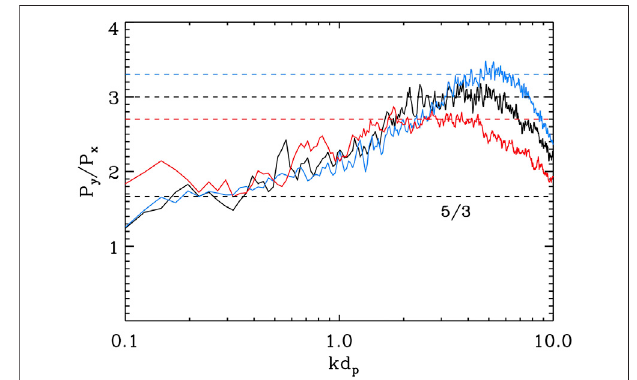
FIGURE 4 | Hybrid simulations: spectra of the ratio of the perpendicular magnetic components P y ( k x ) / P x ( k x ) and corresponding to the local spectral slope. Different colors encode different β p : 0.125 (cyan), 1 (black), and 8 (red). The horizontal dashed lines show reference spectral slopes observed in the simulations at kd p < 1 ( − 5/3) and at sub-ion scales kd p >